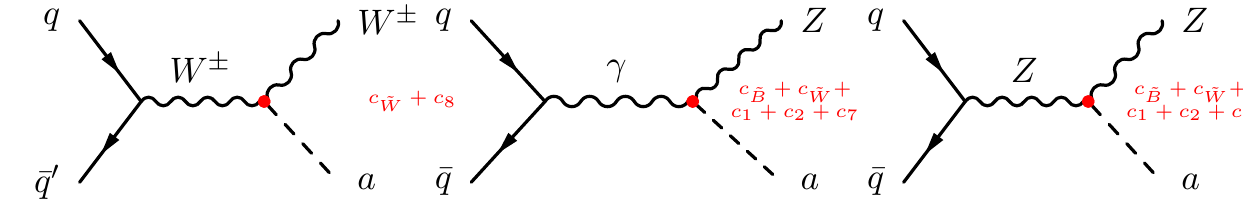
Fig. 2 Feynman diagrams contributing to mono- W and mono- Z production